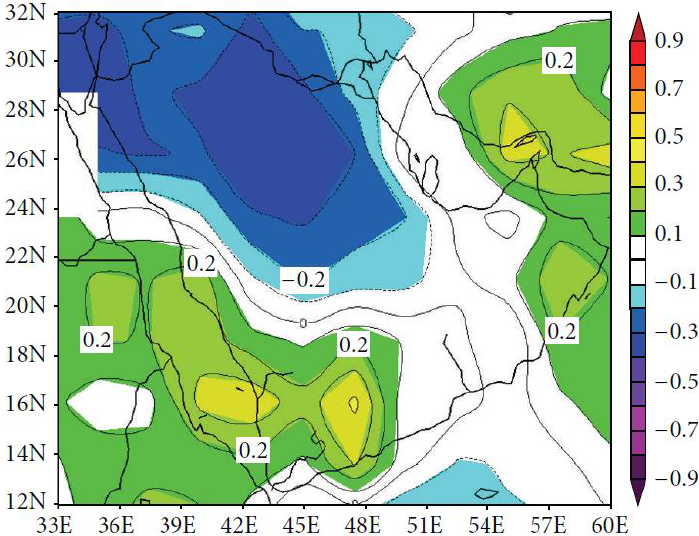
Figure 25. The distribution of the linear correlation coefficient between surface CMAP precipitation (enhanced) over SA and SOI through the period from 1979 to 2011 in summer season [67].